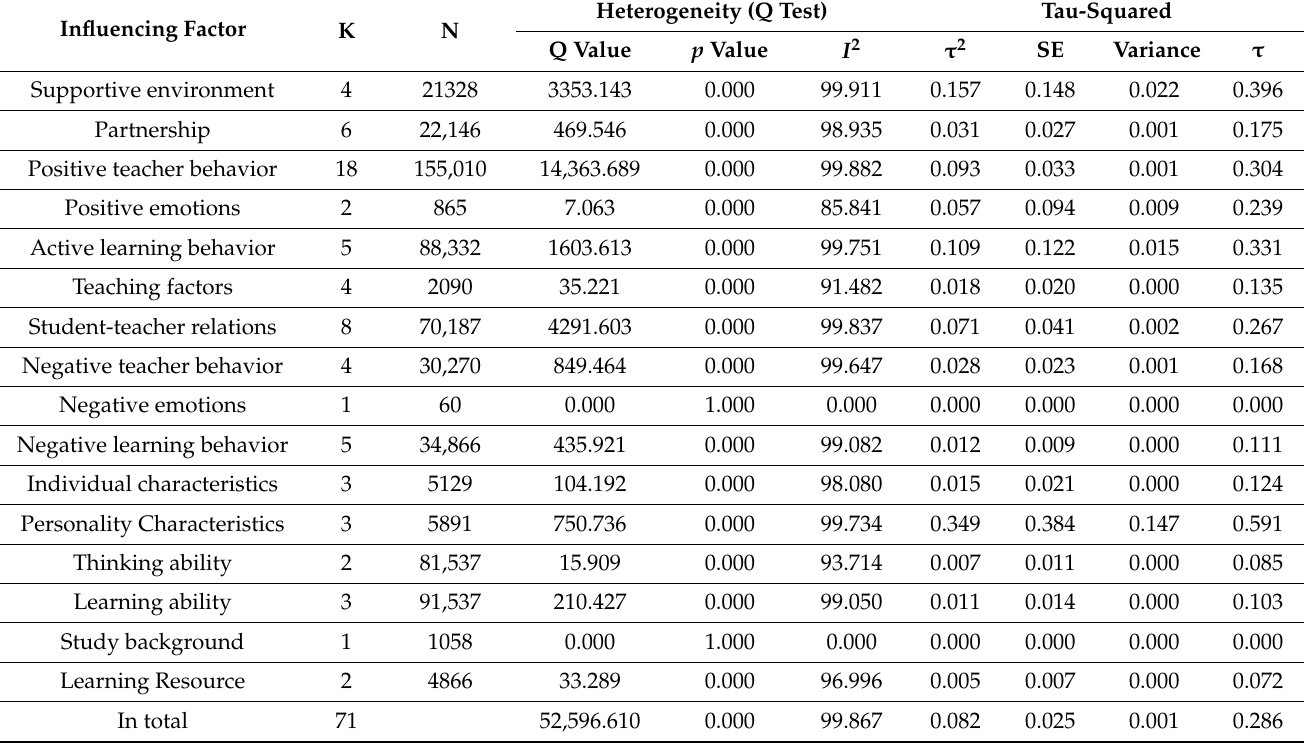
Table 3. Partial results of heterogeneity test.